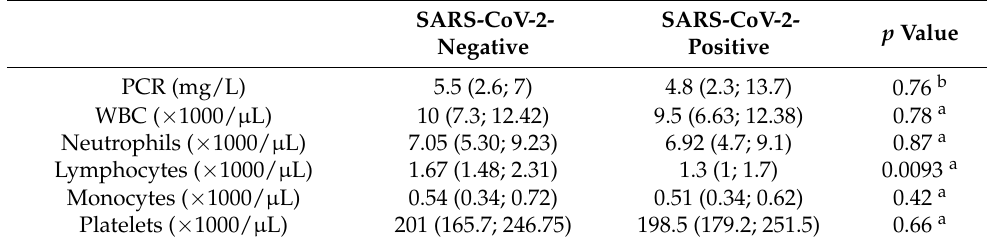
Table 3. Laboratory parameters in maternal blood.